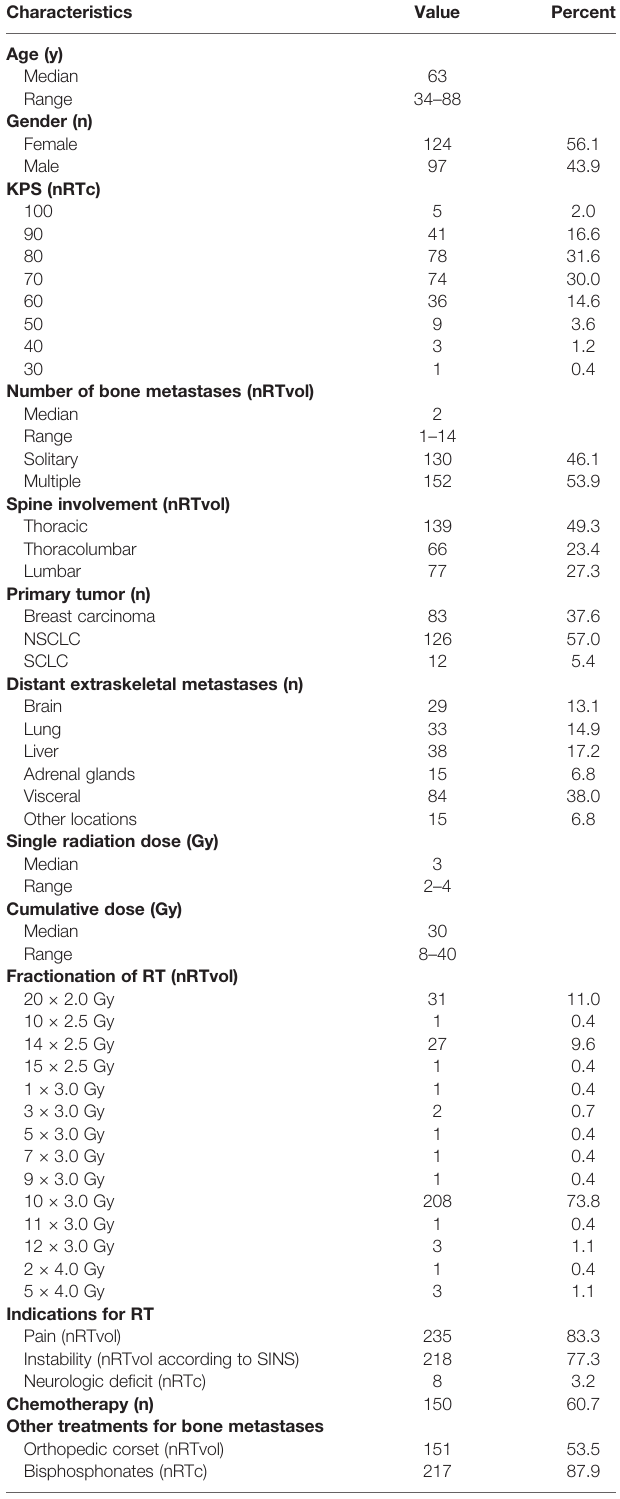
TABLE 1 | Patients ’ and treatment